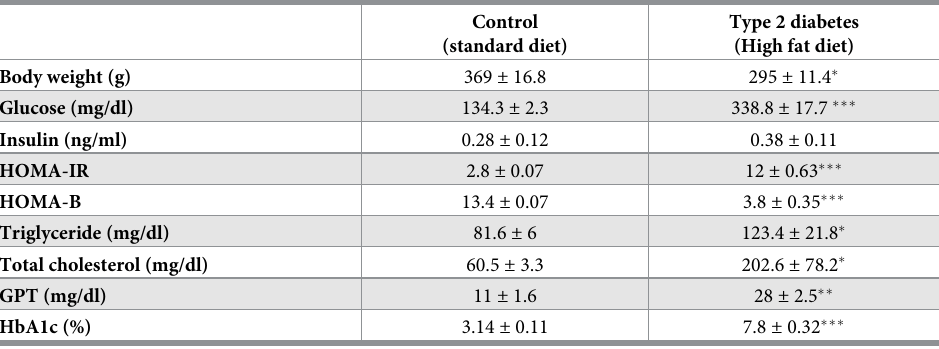
Table 1. Biochemical characteristics of control and diabetic